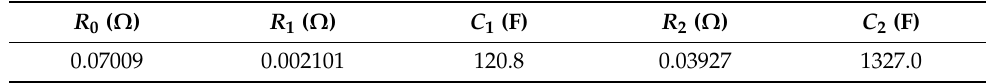
Table 4. Parameter identification results of ECM.